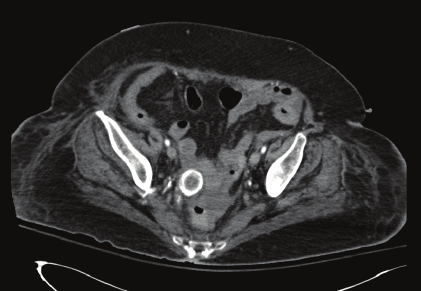
Figure 2: Abdomen and pelvis CT one month prior to obstructive presentation revealing large gallstone resting in the pelvis outside of the bowel